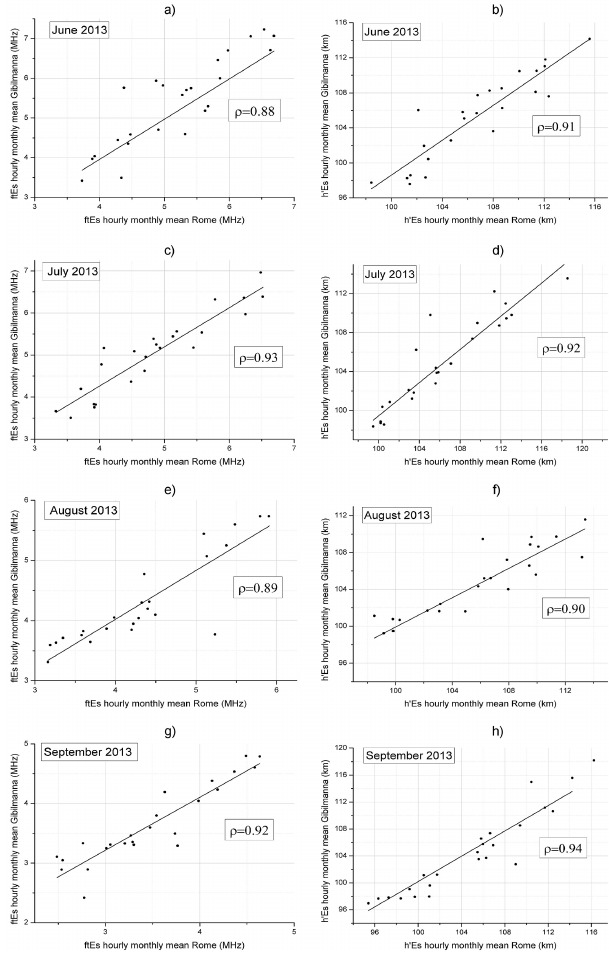
Figure 3. Linear correlation plots of the hourly monthly median ftEs and h’Es values recorded at Rome and Gibilmanna in (a – b) June, (c – d) July, (e – f) August, and (g – h)